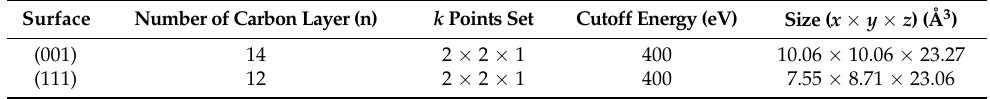
Table 1. Calculation and lattice parameters of the two slab